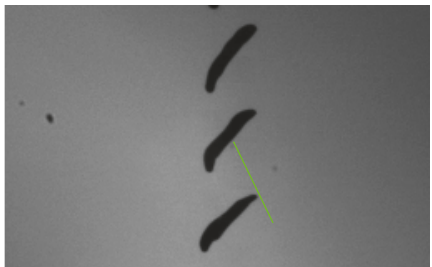
Figure 16: Close-up view of the last snapshot of Figure 15 where the aerodynamic shielding of droplets can be observed in detail (the direction of the slip velocity is drawn in